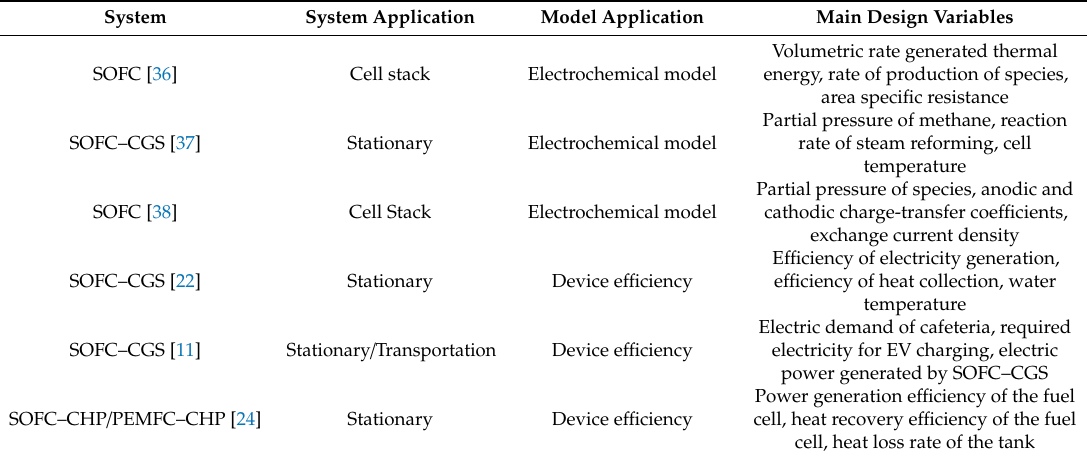
Table 5. Typical approaches of fuel cell